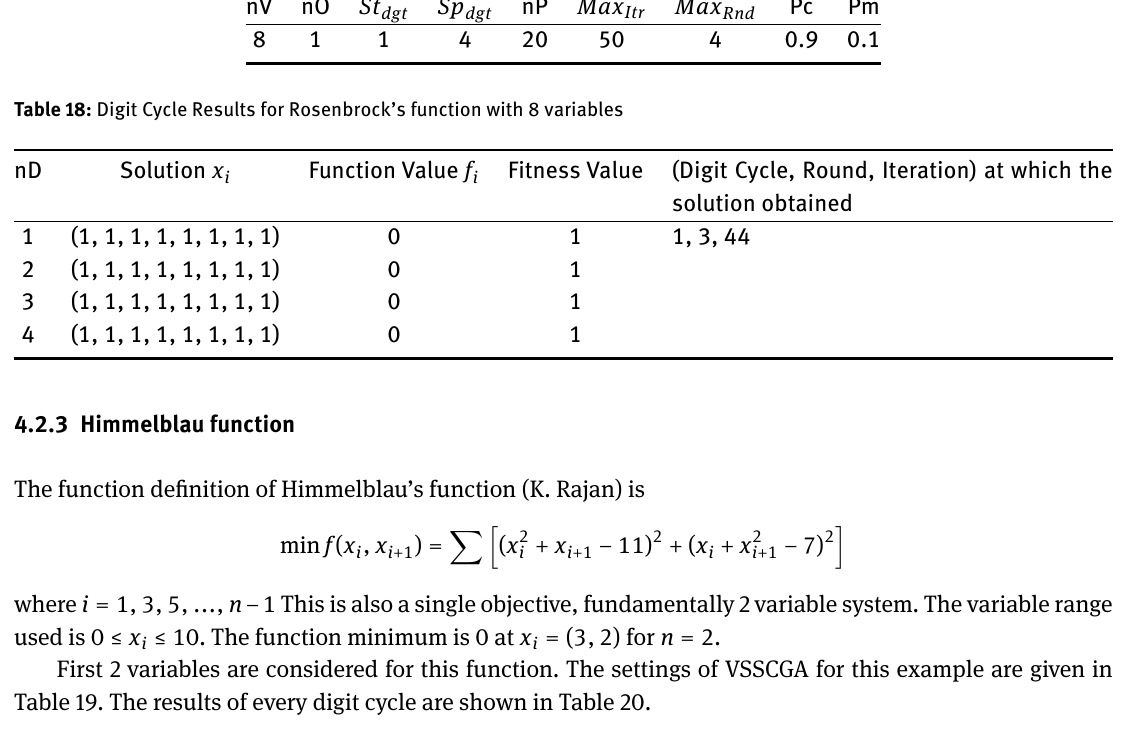
Table 19: VSSCGA Settings for Himmelblau’s function with 2 variables